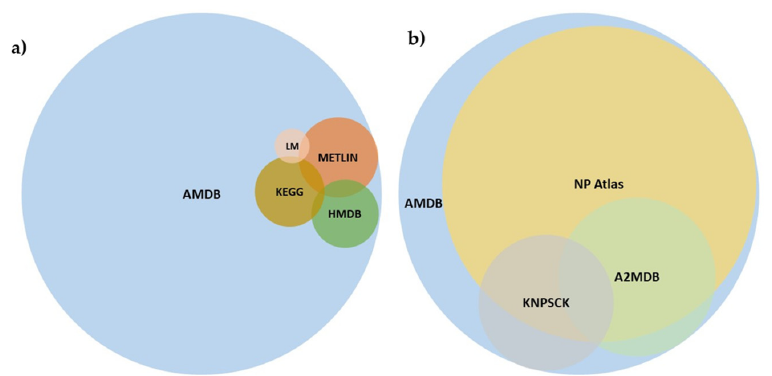
Figure 3. ( a ) Venn diagram of Aspergillus compounds present in general metabolomic databases.